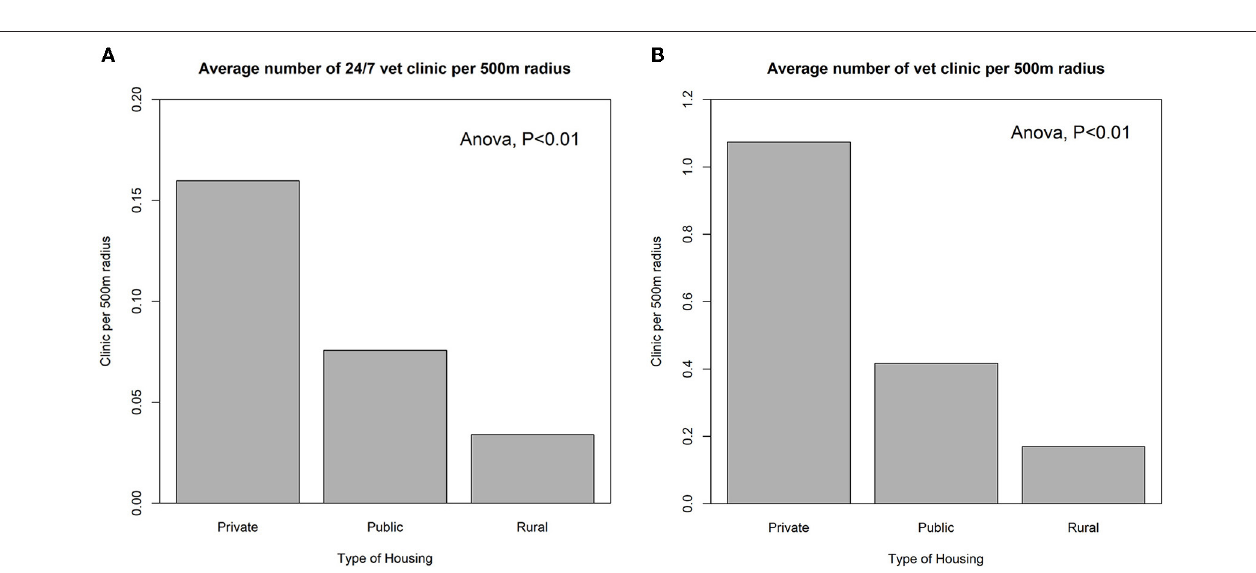
FIGURE 6 | Correlation matrix of accessibility and availability of general and 24/7 vet clinics with demographic characteristics. Correlation with a P -value > 0.05 is left blank.